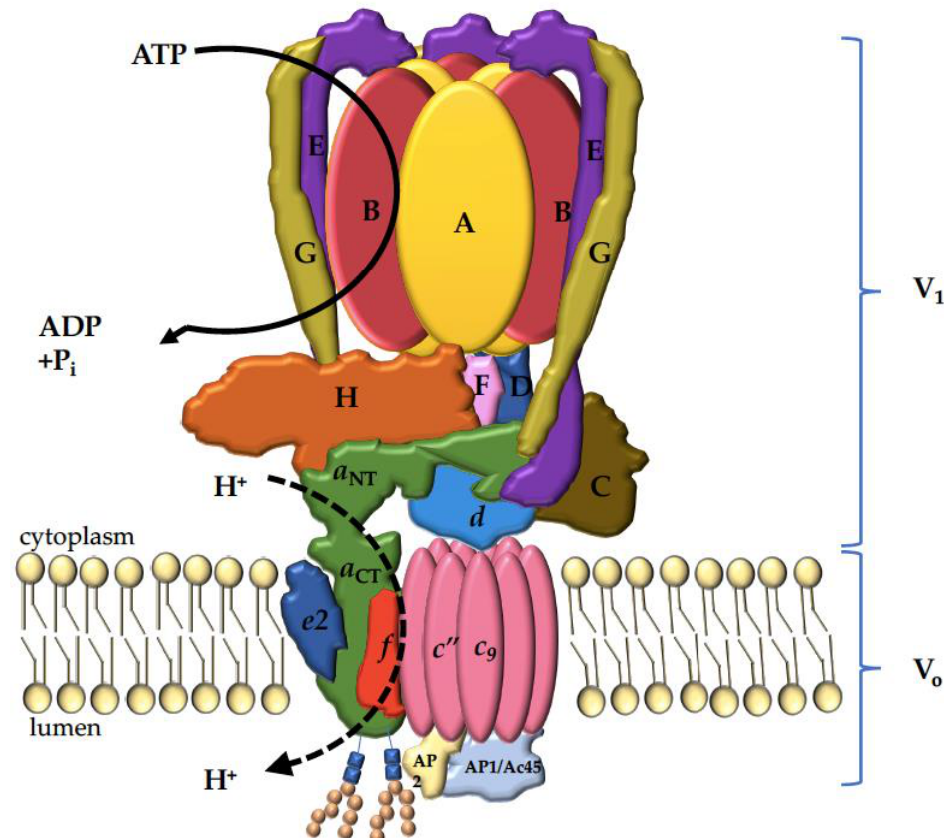
Figure 1. Mammalian V-ATPase complex. Cytosolic sector V 1 , comprised of A 3 B 3 CDE 3 FG 3 H, is responsible for the ATP hydrolysis, which generates the force required to drive the rotation of the proteolipid c -ring ( c 9 c ″ ) of the membrane-bound V O consisting of ac 9 c ″ def AP1AP2. The a CT forms two half-channels that create a pathway for protons to cross the lipid bilayer as the c -ring rotates. Both a 2 and a 3 orthologs are glycosylated twice on the first luminal loop within the C-terminus (depicted here), whereas a 1 and a 4 are only glycosylated once [82].